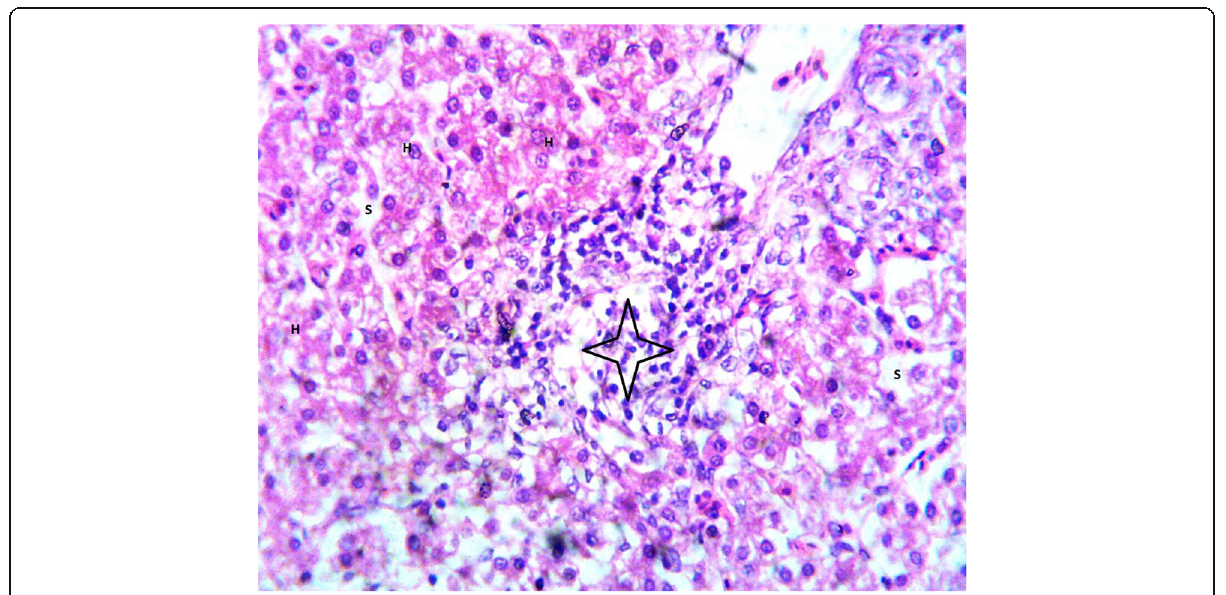
Fig. 5 Representative micrograph of liver section (× 400) of broiler chicks fed 0.8% PCM supplemented diet. This section shows activation of liver